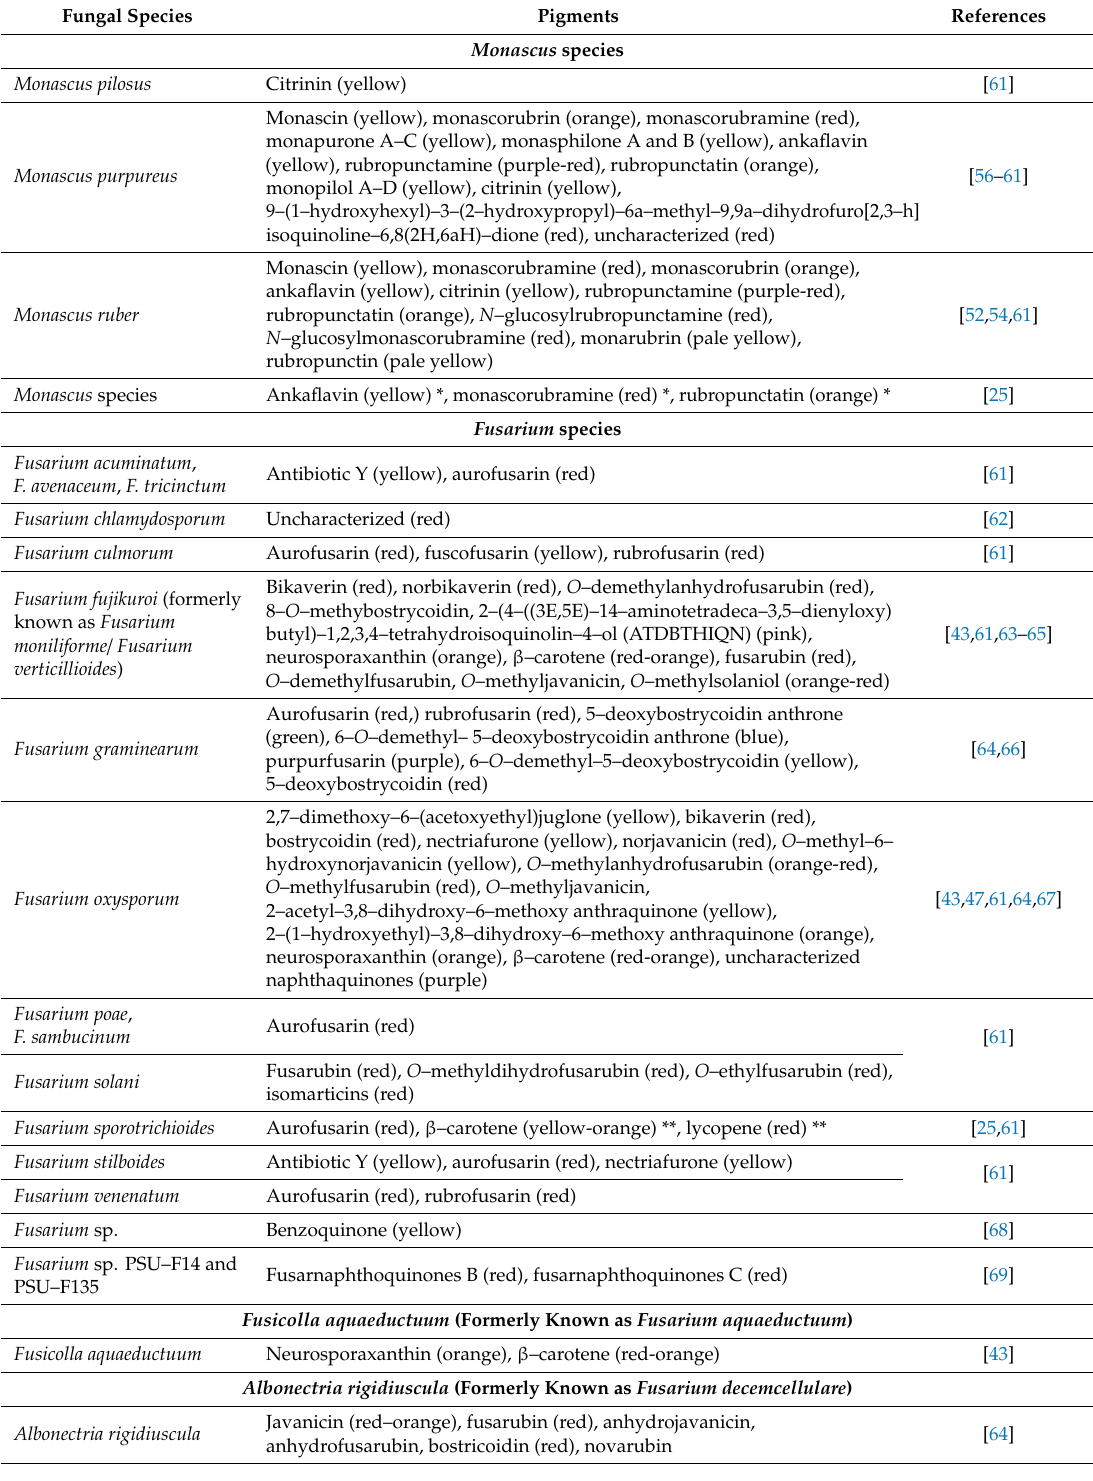
Table 1. Updated list of pigment-producing fungi and their respective pigments